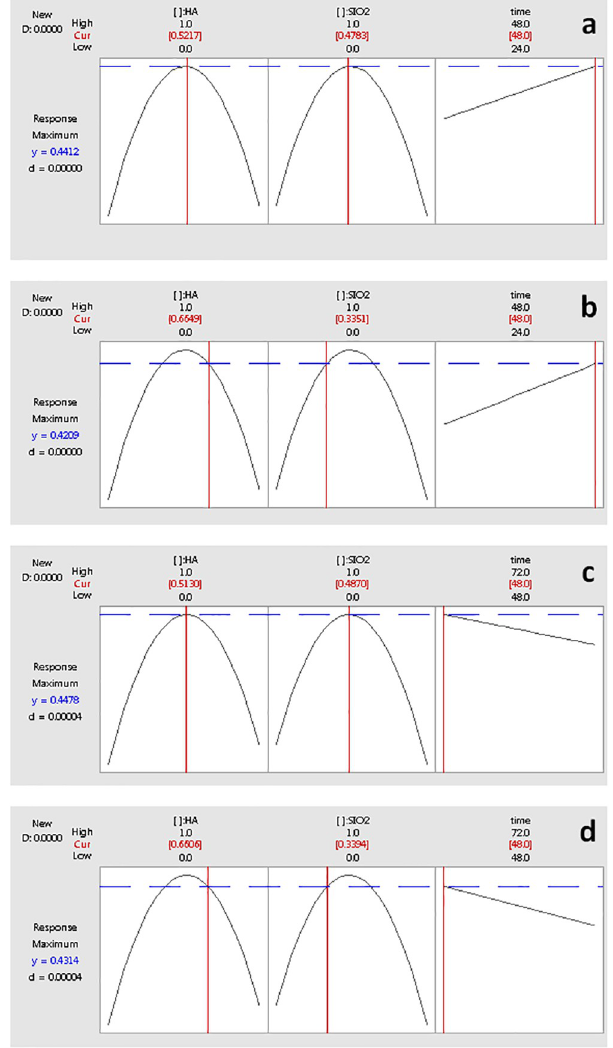
Fig 7. Maximum Optimal Response Comparison (a) at (0.512, 0.4783, 48) versus (0.6649, 0.3351, 48), and (b) at (0.513, 0.487, 48) versus (0.6606, 0.3394, 48).